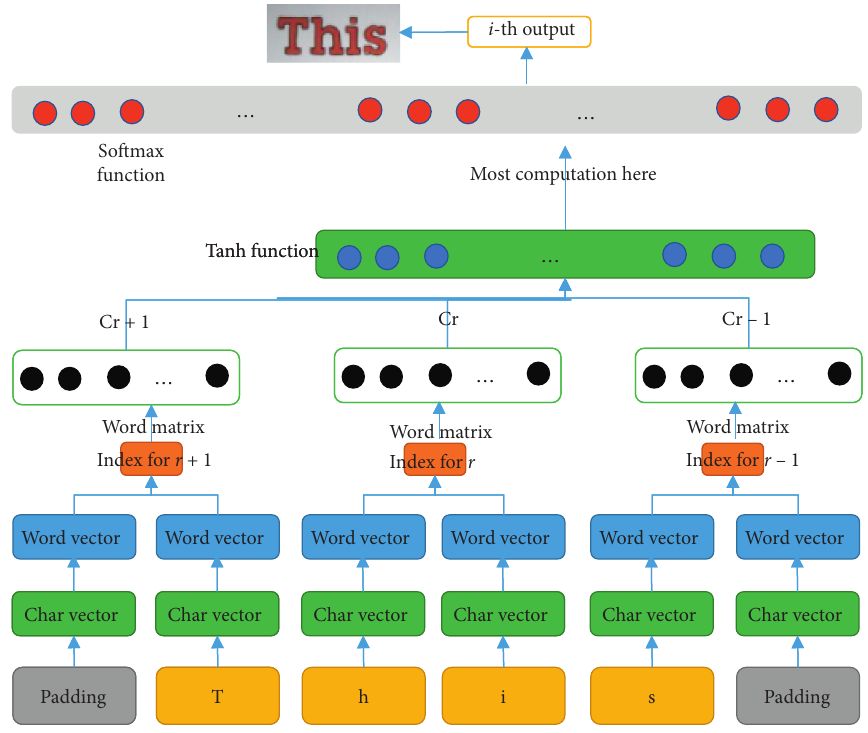
Figure 2: CRNN network